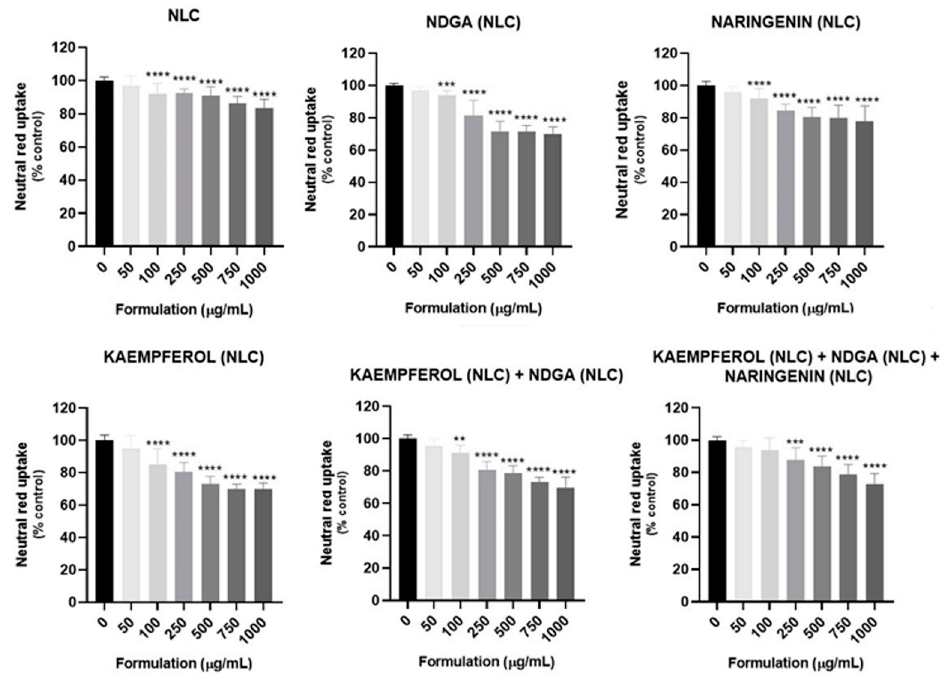
Figure 3. Cytotoxicity of the developed formulations evaluated in HaCaT cells by the neutral red (NR) uptake assay 24 h after exposure. Results are expressed as mean ± SD from four independent experiments performed in triplicate. Statistical comparisons were made using one-way ANOVA followed by the Dunnett’s multiple comparisons test (for data with a parametric distribution) or using the Kruskal–Wallis test followed by the Dunn’s multiple comparisons test (for data with a non-parametric distribution) ** p < 0.01; *** p < 0.001; **** p < 0.0001 (for each formulation vs. 0 µ g/mL). In all cases, p values < 0.05 were considered significant.